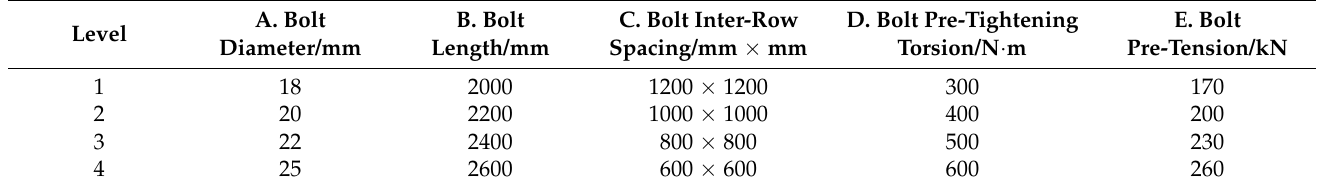
Table 6. Experimental factor scheme of orthogonal numerical